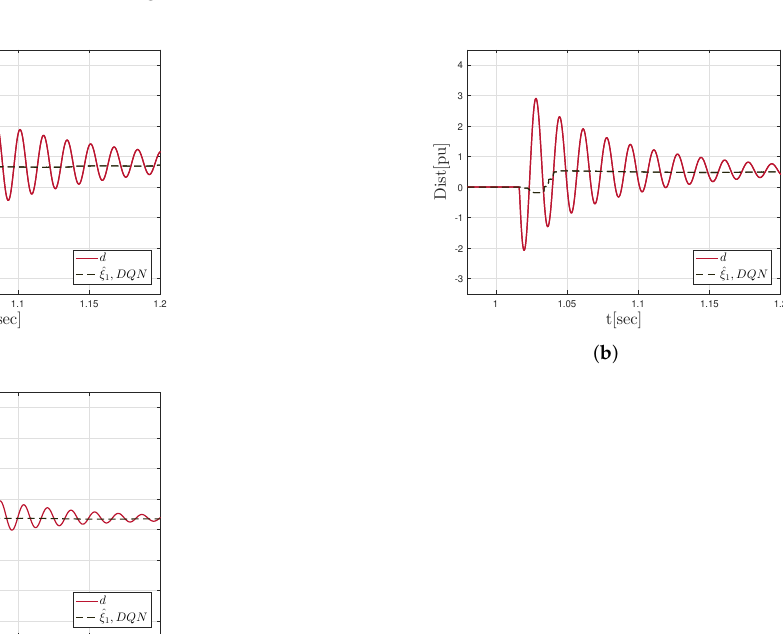
Figure 16. RTDS-based HILS configuration.